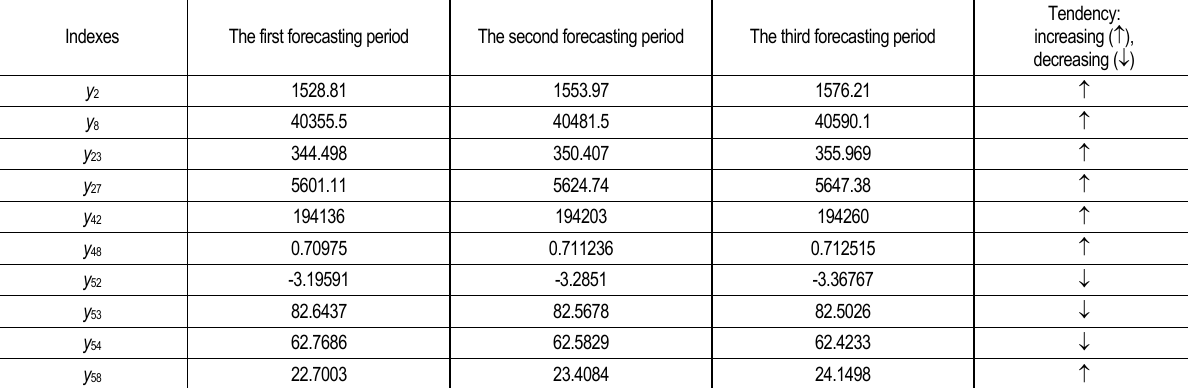
Table 6. Forecasting meanings of indexes of socioeconomic state of India